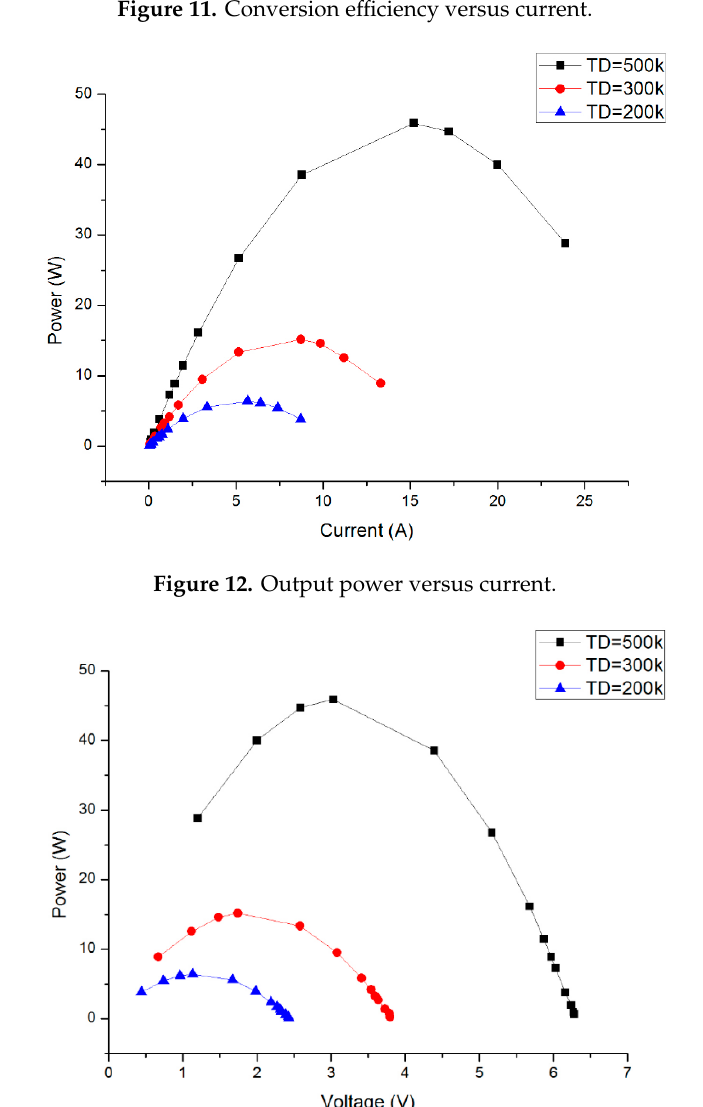
Figure 11. Conversion efficiency versus current.